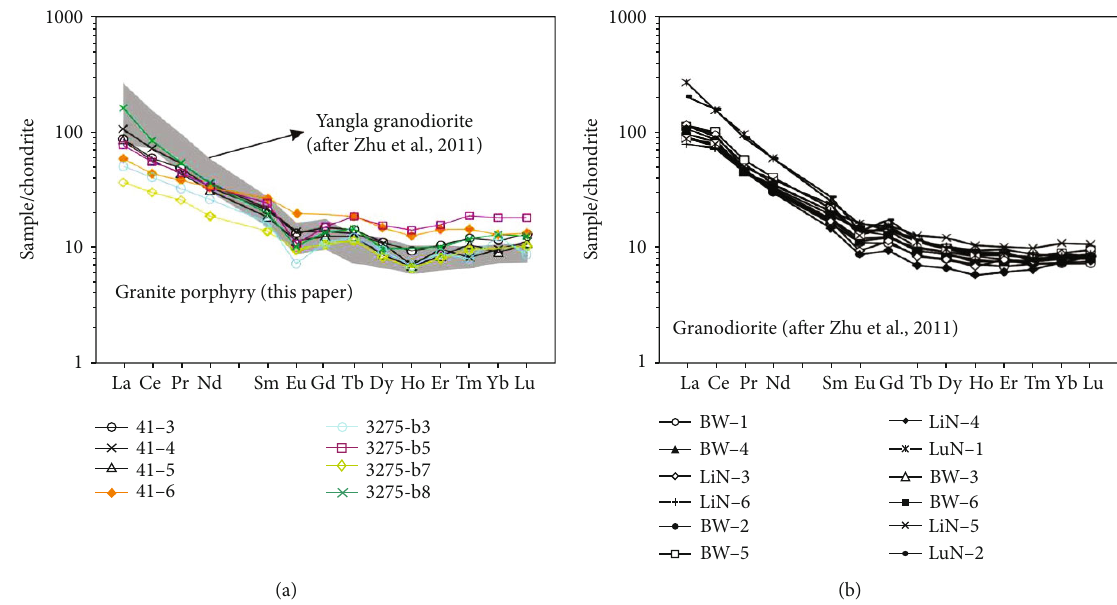
Figure 15: Chondrite-normalized REE patterns of the granite porphyries (a) and granodiorite (b) in Yangla copper deposit, Yunnan, China (after Sun and Mcdonough, 1989 [79]).